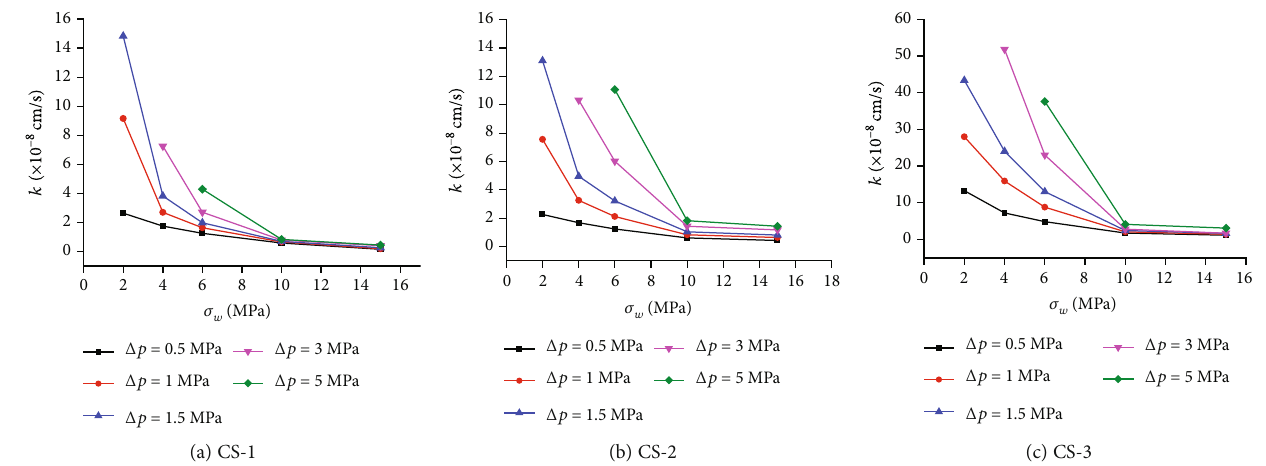
Figure 17: Relationship between permeability coe ffi cient and con fi ning pressure for CS.